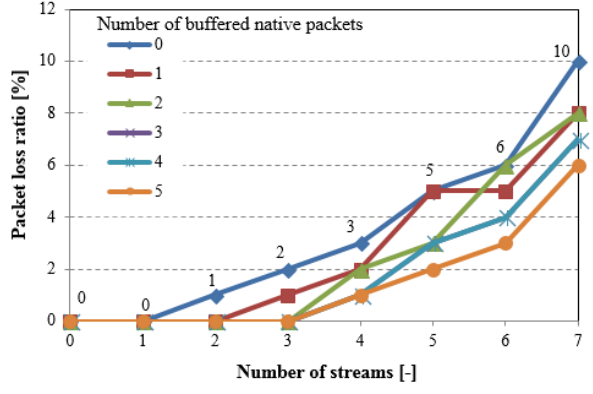
Figure 8. End-to-end packet delay (simple testing scenario).